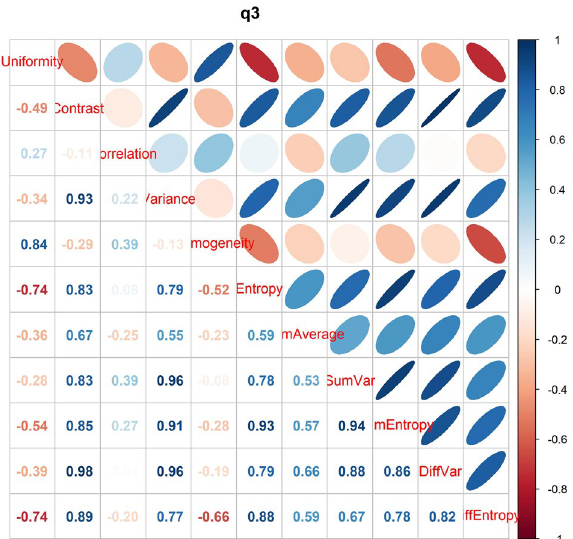
Figure 4. Correlation between variables within direction q3, chosen as reference for being the intermediate between all assessed directions. The high correlation of the textural parameters sum variance, sum entropy, variance of difference and entropy of difference with at least one remaining parameters is here